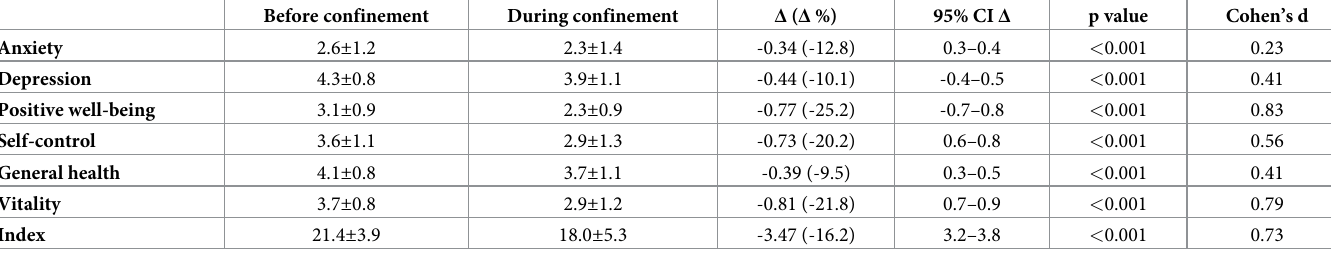
Table 3. This is the psychological general well-being index before and during the COVID-19 quarantine period. Before